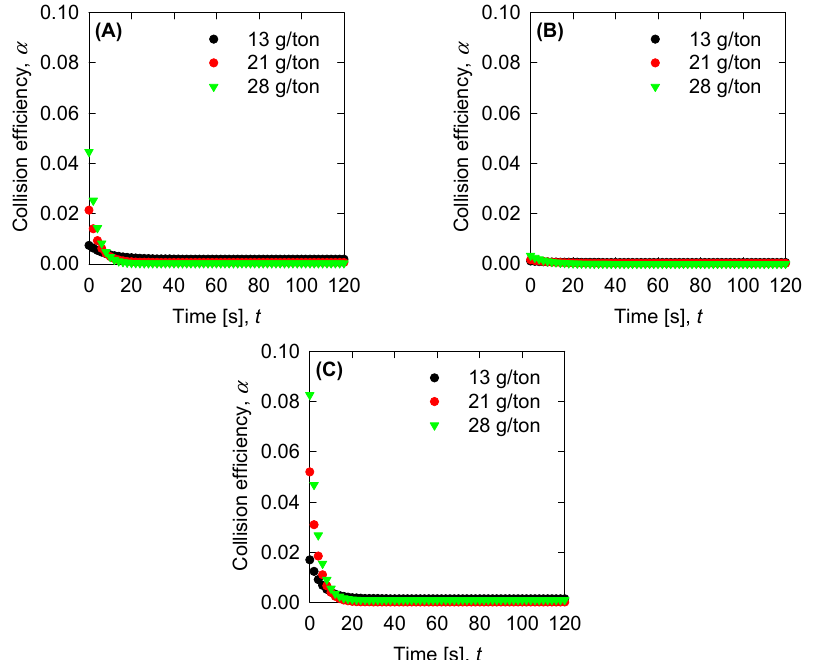
Figure 8. Collision efficiency for the experimental data for ( A ) SW pH 8, ( B ) SW pH 11, and ( C ) T-SW pH 11.